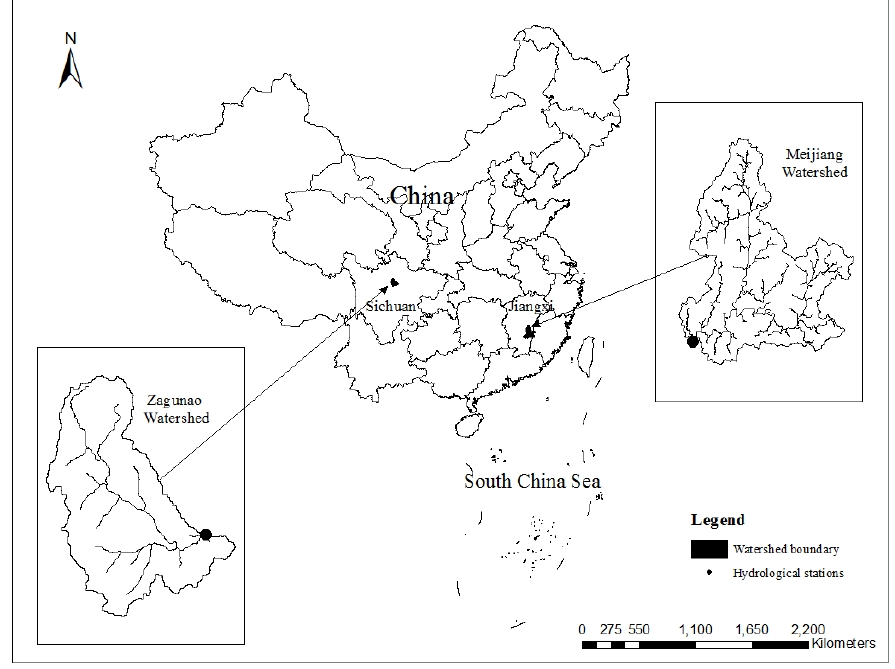
Figure 1. The location of the study watersheds.